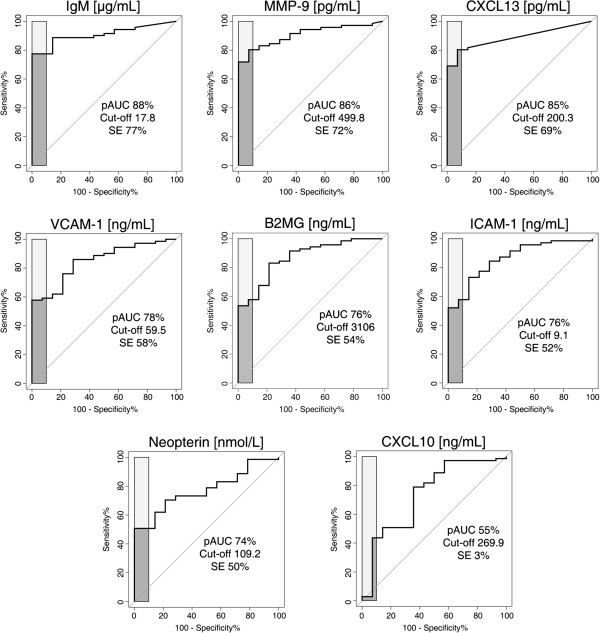
ROC curves representing the staging abilities of the eight markers. Dark gray areas represent the corrected pAUC between 90 and 100% of specificity obtained for each marker. Light gray zones represent a pAUC of 100%. The value of the cut-off corresponding to 100% specificity comprised within the pAUC is reported on each graph together with the corresponding sensitivity% (SE%). Additional results are reported in Additional file 1: Table 2.